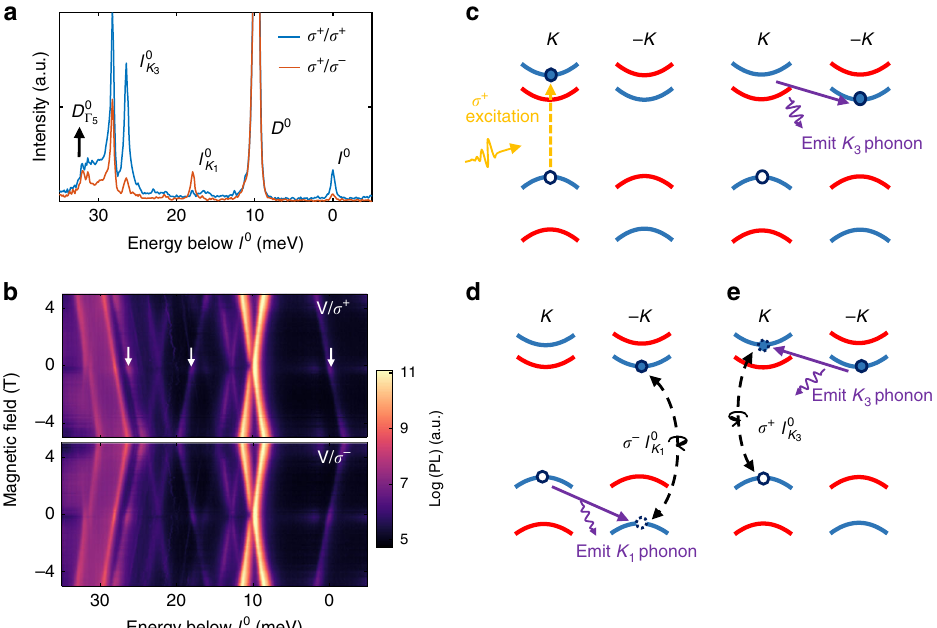
Fig. 4 Identi fi cation of intervalley dark exciton and its valley phonon replicas. a Circular polarization resolved PL in the neutral regime. The photon energy of the spectrum is offset with respect to the intervalley exciton ( I 0 ). b Magneto PL with linearly polarized excitation, σ + (up) and σ − polarized (down) detection. I 0 K , I 0 K and I 0 are labeled by the white arrows, from left to right. c Schematic of intervalley exciton formation process under σ + excitation, 3 1 with assistance of K 3 phonon. d , e Schematic of light emission process of I 0 K